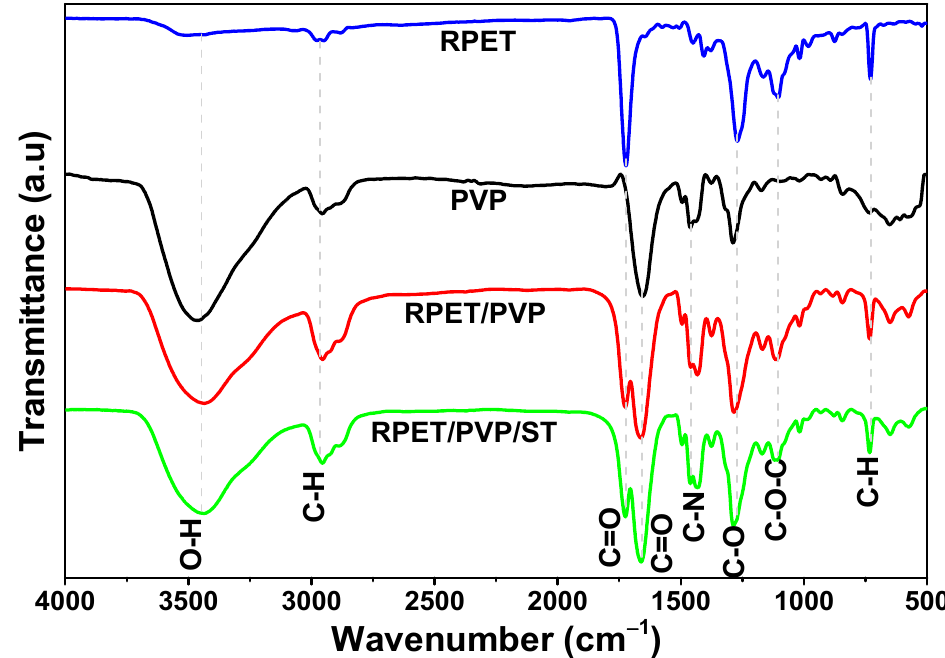
Figure 4. Infrared spectra of RPET, PVP, RPET/PVP, and RPET/PVP/ST